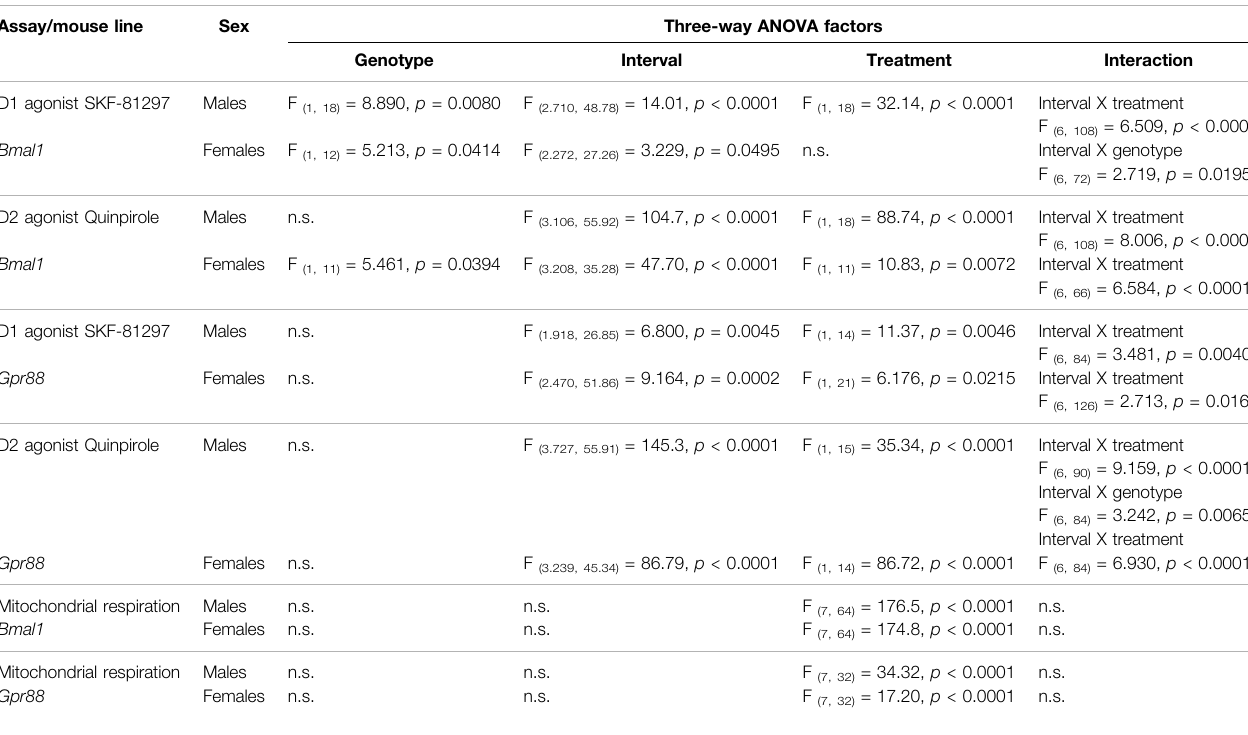
TABLE 3 | Statistical analysis of dopamine receptor agonist treatment and mitochondrial respiration. Assay/mouse